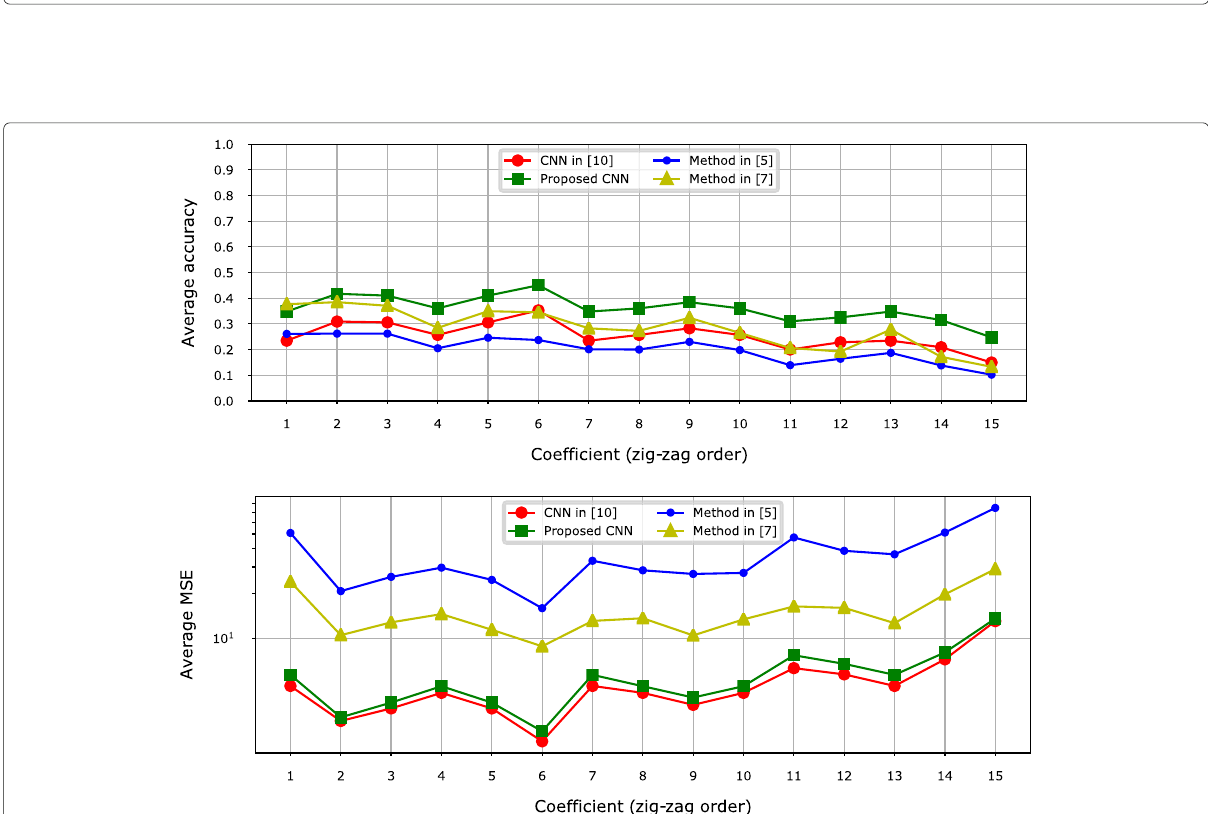
Fig. 6 Average accuracy (top) and MSE (bottom) of the estimation for each of the 15 DCT coefficients, for QF 2 = 80, in the non-aligned DJPEG scenario